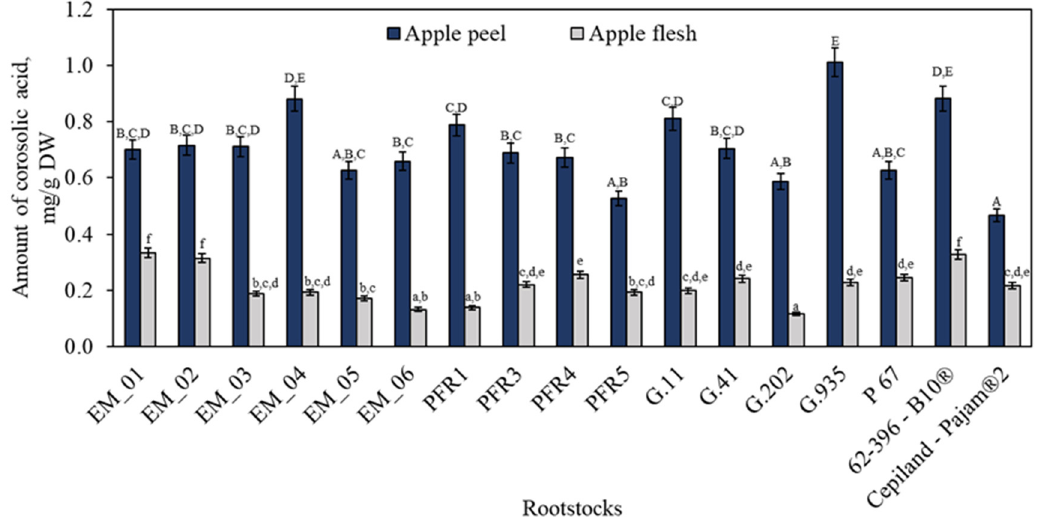
Figure 4. Influence of rootstocks on the quantitative composition of corosolic acid. The means followed by different uppercase and lowercase letters are significantly different at p < 0.05.